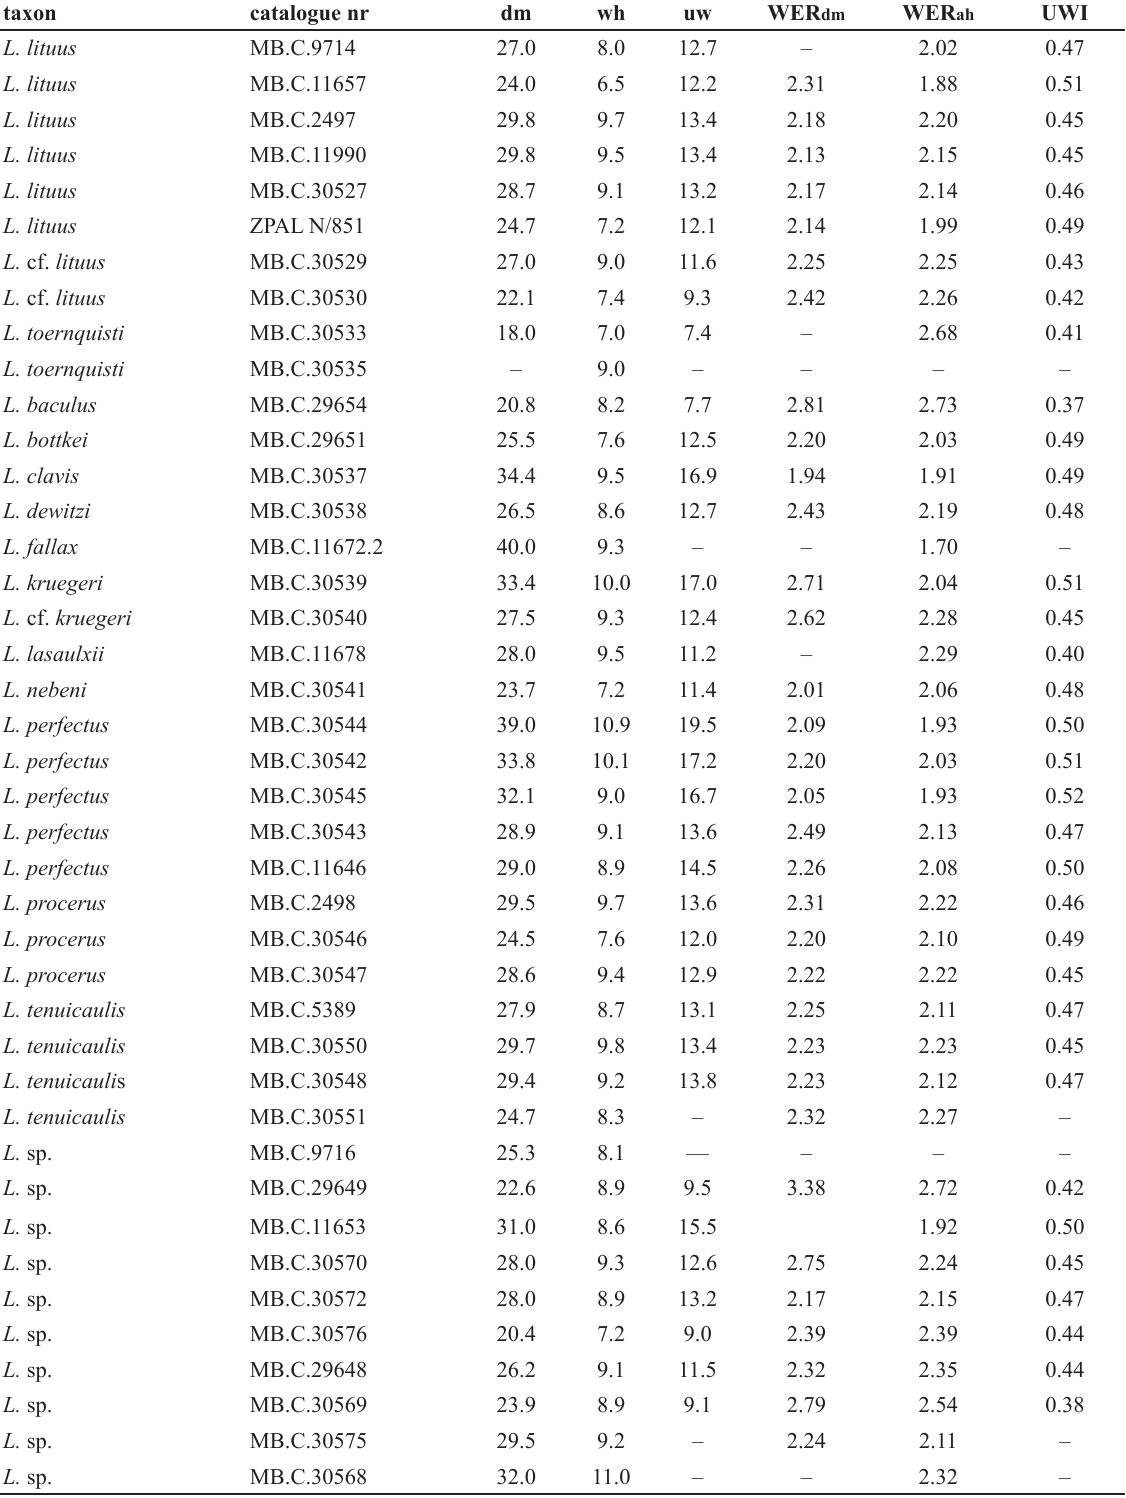
Table 9. Conch measurements (in mm), ratios and rates of coiled conch parts of Lituites Bertrand,